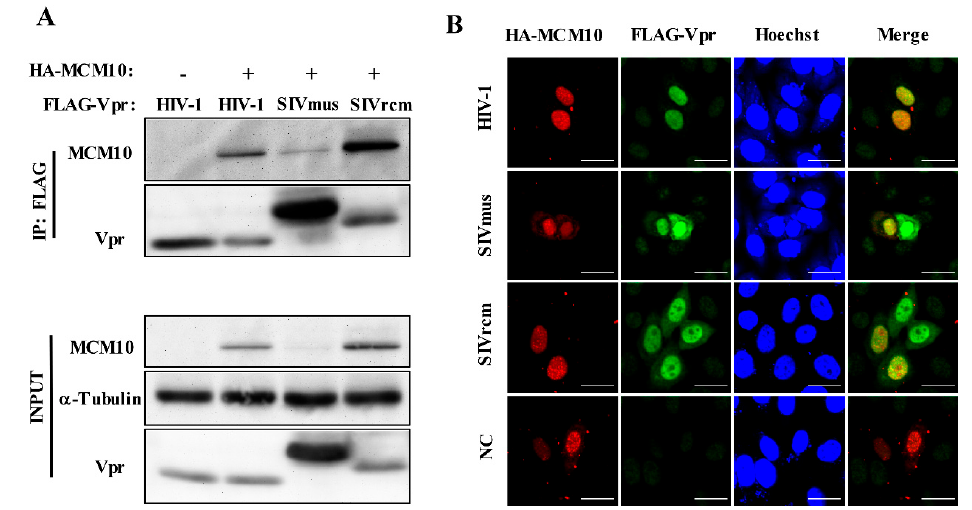
Figure 4. MCM10 interacts and colocalizes with HIV-1, SIVmus, and SIVrcm Vprs. ( A ) HEK293T cells transiently transfected with either pcDNA 3.1 / HA-MCM10, or the control, pcDNA 3.1, together with either pcDNA3.1 / 3 × FLAG-HIV-1, SIVmus, or SIVrcm Vprs. At 48 h following transfection, cell lysates were collected and incubated overnight with anti-FLAG agarose beads. Subsequently, cell lysate inputs and agarose beads were collected, washed, and subjected to western blotting with anti-HA mouse mAb followed by HRP-conjugated goat anti-mouse IgG for detection of MCM10, of anti-FLAG mouse mAb followed by HRP-conjugated goat anti-mouse IgG for detection of Vprs. The positions of 3 × FLAG-Vpr, HA-MCM10 and α -Tubulin are indicated. ( B ) HeLa cells on the cover glass were transiently transfected with pcDNA 3.1 / HA-MCM10 together with either pcDNA3.1 / 3 × FLAG-HIV-1, SIVmus and SIVrcm Vprs, or the control, pcDNA3.1 / 3 × FLAG. At 48 h following transfection, cells were stained with anti-FLAG rabbit mAb followed by Alexa Fluor 488 goat anti-rabbit IgG to detect Vpr (green), with anti-HA mouse mAb followed by Alexa Fluor 594 goat anti-mouse IgG to detect MCM10 (red), and with Hoechst 33342 to detect nucleus (blue) and observed using a FV-1000 fluorescence microscope. Merged images (orange) indicate localization pattern of both proteins. Bar = 20 μ m.